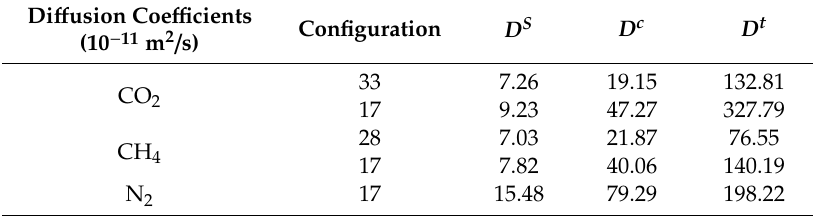
Table 2. Di ff usion coe ffi cients of CO 2 , CH 4 , and N 2 in the vitrinite (298 K and 0.1